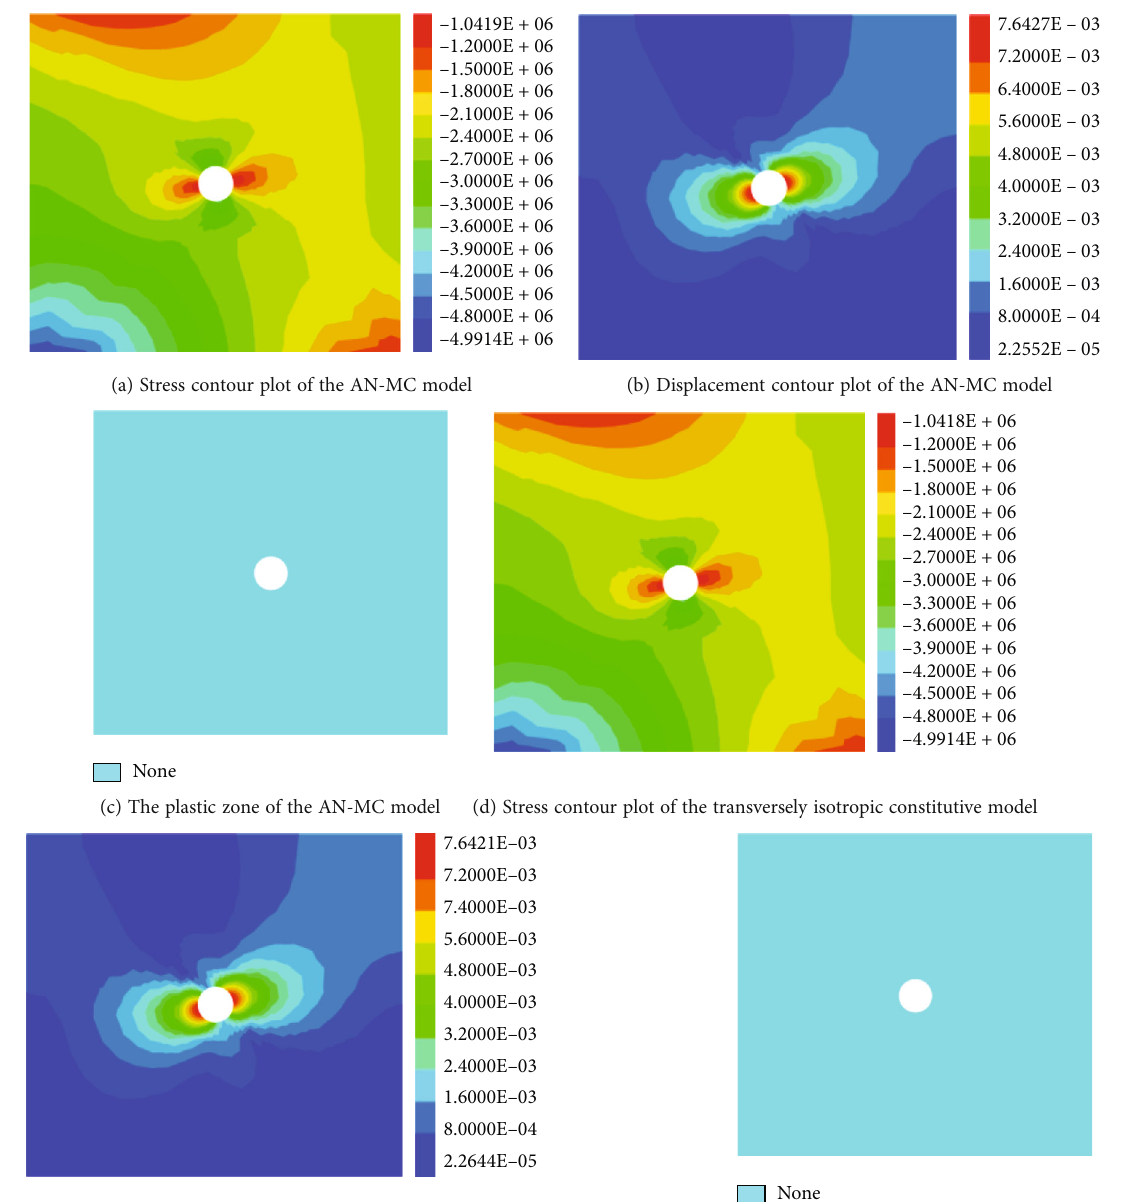
Figure 3: Comparison of stress, displacement contour plot, and plastic zone under di ff erent constitutive